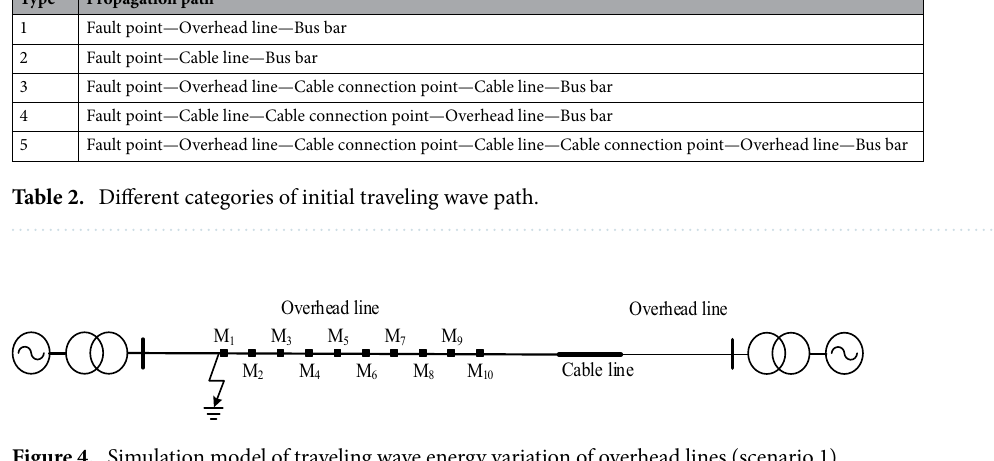
Figure 4. Simulation model of traveling wave energy variation of overhead lines (scenario